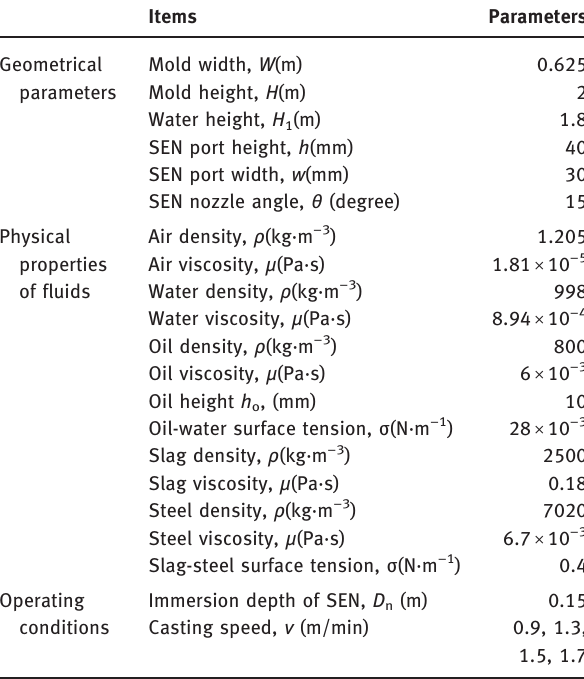
Table 1: The geometrical parameters, operating conditions, and physical properties of